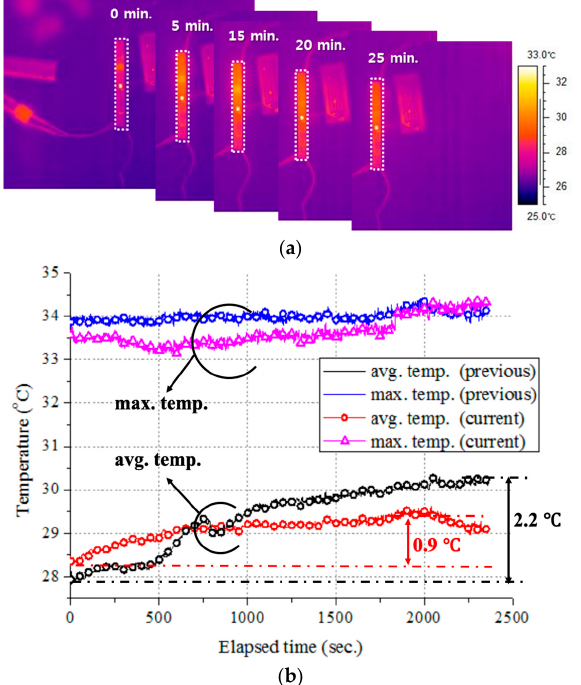
Figure 21. Measured thermal characteristics of the revised SoB using a thermal analysis: ( a ) Snapshots of the thermal distribution and ( b ) temperature changes.